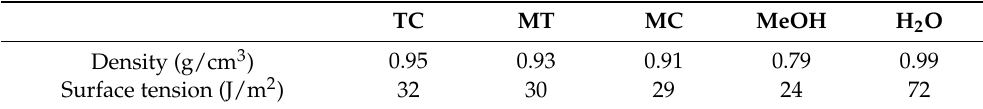
Values of density and surface tension measured for the obtained VNADESs and control extractants.